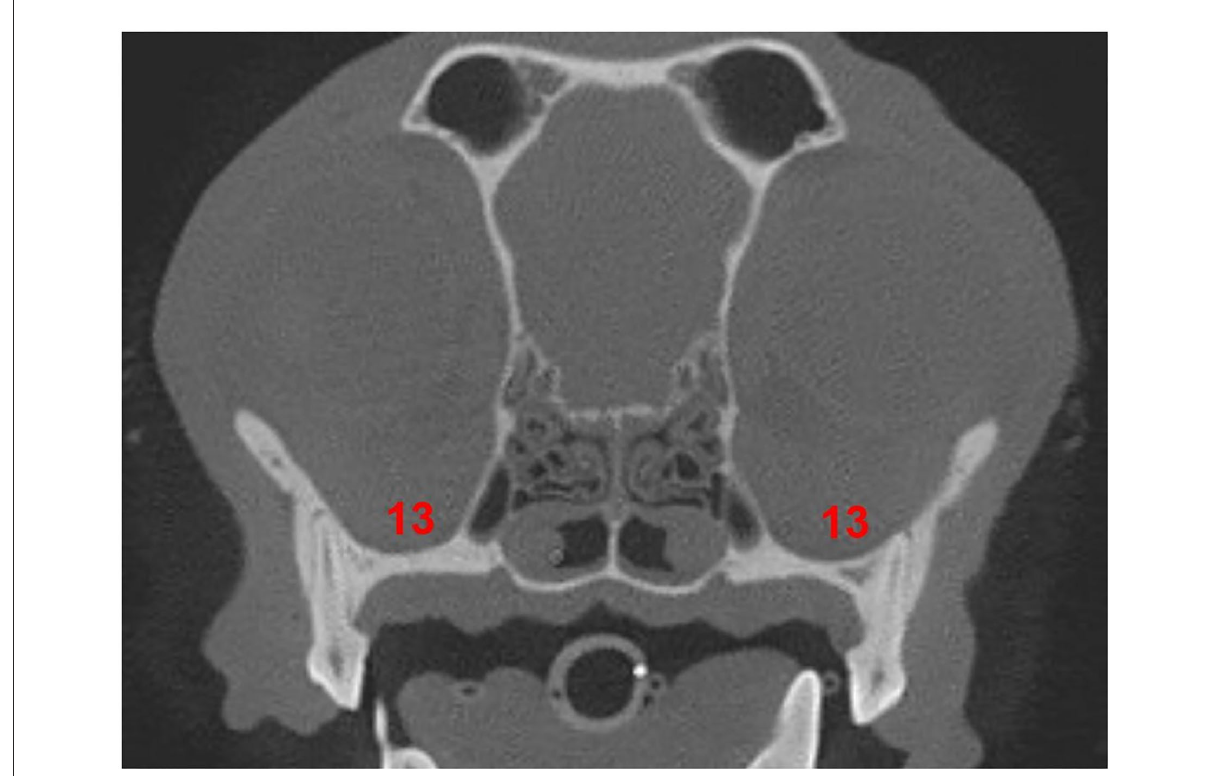
FIGURE3 Section 13 relative to the roots of the P4. (13) Section 13: caudal to the maxillary foramen/ floor of the